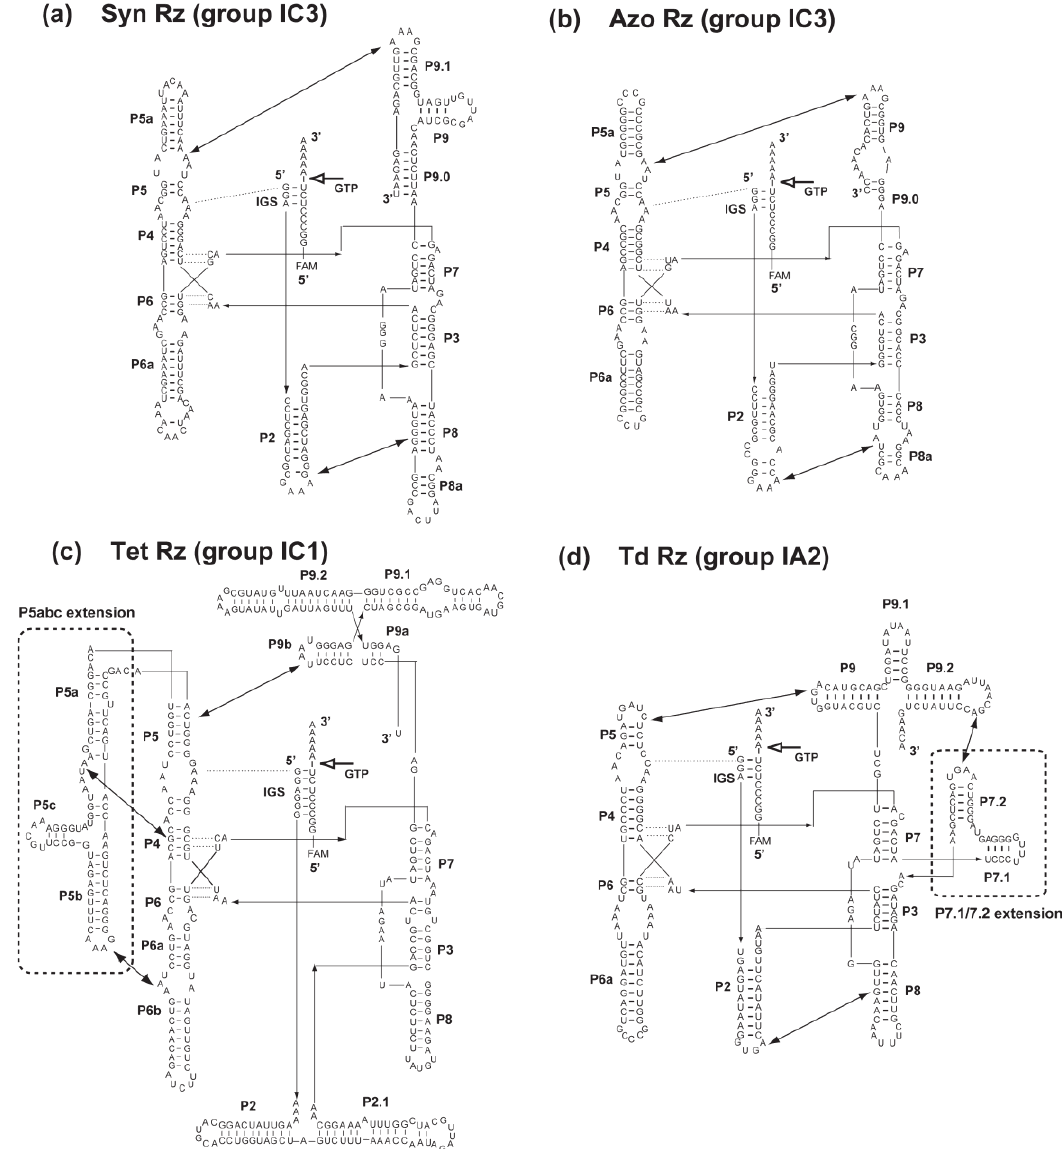
Figure 2. Secondary structures of four group I ribozymes employed in this study. They are Syn group IC3 Rz ( a ), Azo group IC3 Rz ( b ), Tet group IC1 Rz ( c ), and Td group IA2 Rz ( d ). Each ribozyme cleaves a common substrate RNA, which is recognized by the IGS element in each ribozyme. Solid lines with two closed arrows indicate tertiary interactions. Broken lines indicate base triplet interactions that contribute to recognition of the cleavage site by the catalytic core and support the assembly of two core domains. White arrows indicate the GTP-dependent cleavage site in the substrate RNA. Regions enclosed with broken lines indicate the P5abc extension in Tet Rz ( c ) and the P7.1/7.2 extension in Td Rz ( d